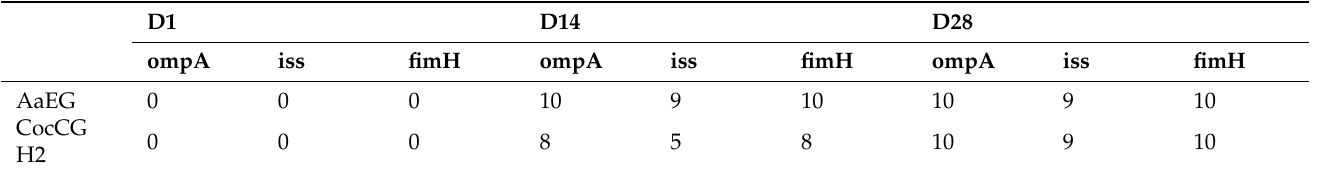
Table 6. The number of positive samples using APEC genetic screenings in chickens treated with A. annua compared to chickens treated with